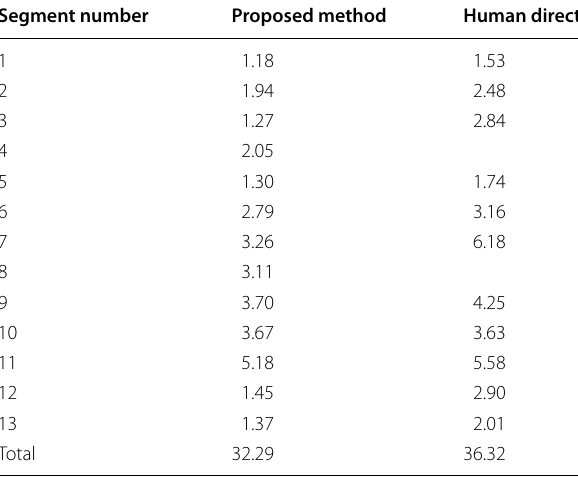
Table 1 Average execution time of the experiments